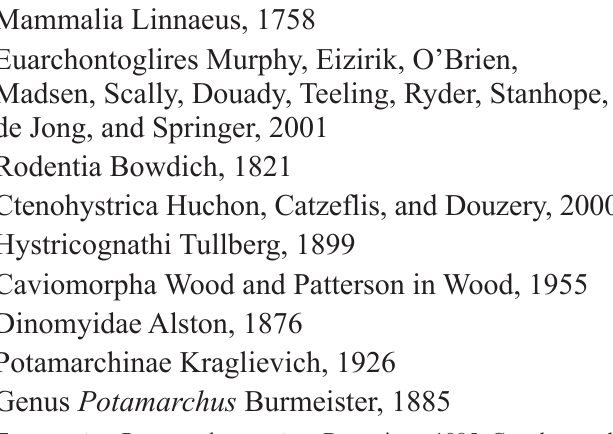
Fig. 1. Location of the studied area ( A ) and fossiliferous localities in southwestern Amazonia, Brazil ( B ). Localities: 1, Cantagalo; 2, Talismã; 3, Lula; 4, Patos; 5, Cachoeira do